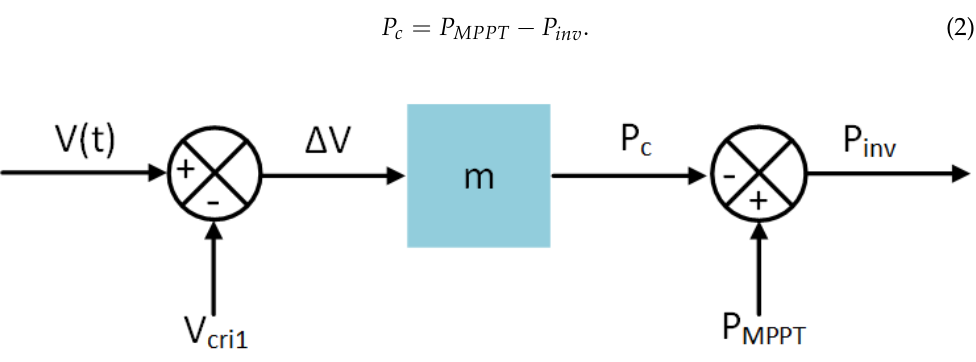
Figure 1. Droop-based active power curtailment (APC) method for LV distribution networks with PV